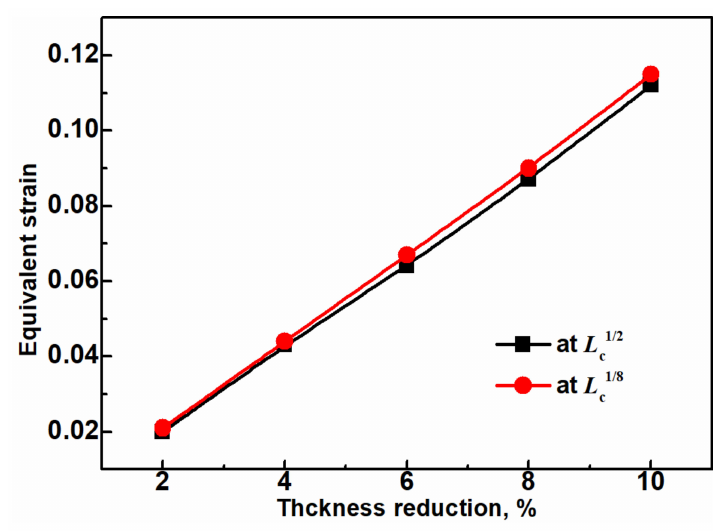
Figure 13. Equivalent strain at the slab center of 1/8 width ( L c1/8 ) and 1/2 width ( L c1/2 ) after different HR deformation implemented at the strand solidification